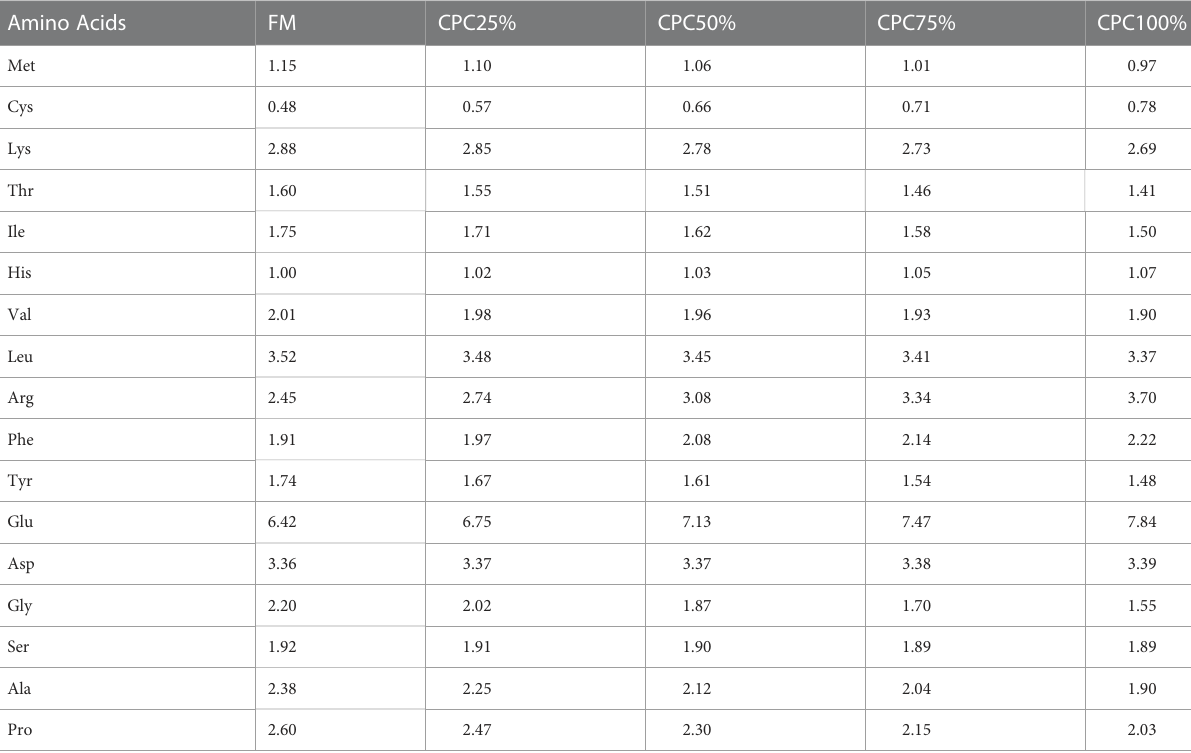
TABLE 2 Amino acid composition of the experimental diets (% dry matter). Amino